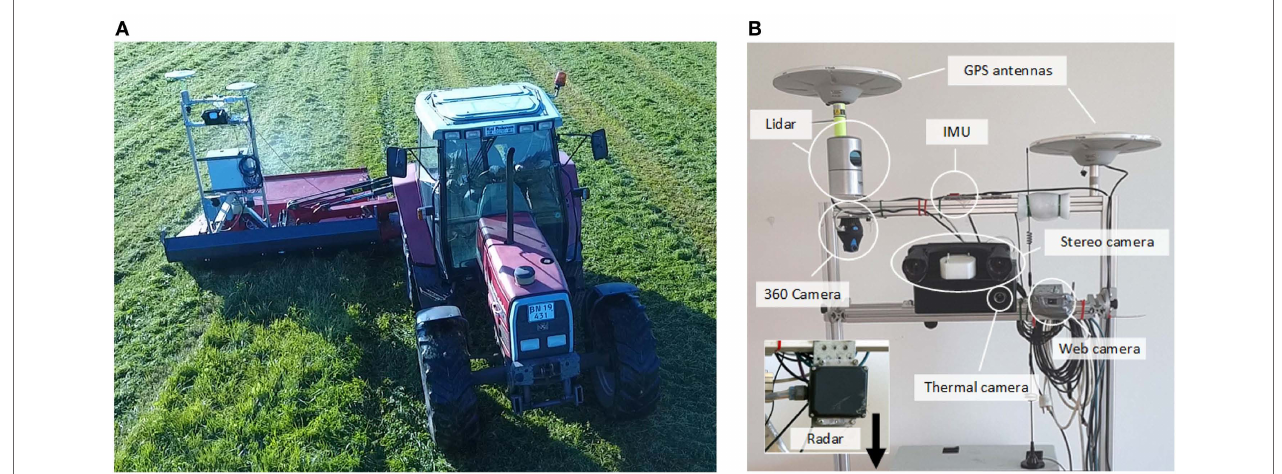
FIGURE 2 | Recording platform. (A) Platform attached to tractor-mounted mower. (B) Sensor setup. Reprinted from Kragh et al. (2017) with permission.